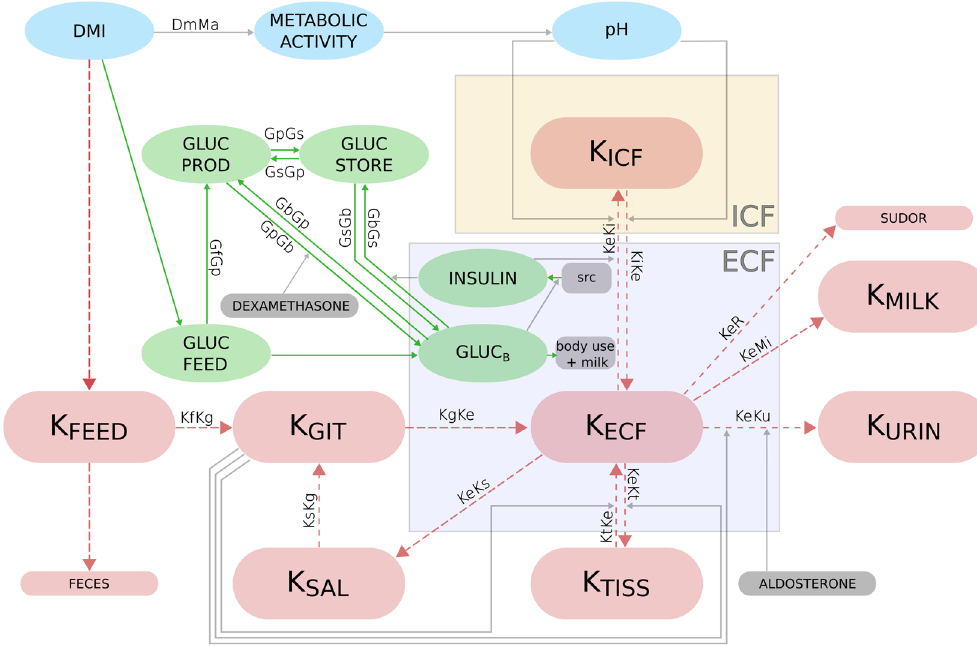
Figure 1. Schematic representation of the components and their relationships in the mechanistic model of potassium balance in cows. Each box represents a model component. The pink color represents potassium, green boxes correspond to metabolic components, and gray arrows and boxes indicate stimulatory or inhibitory effects. All components are fully explained in Table